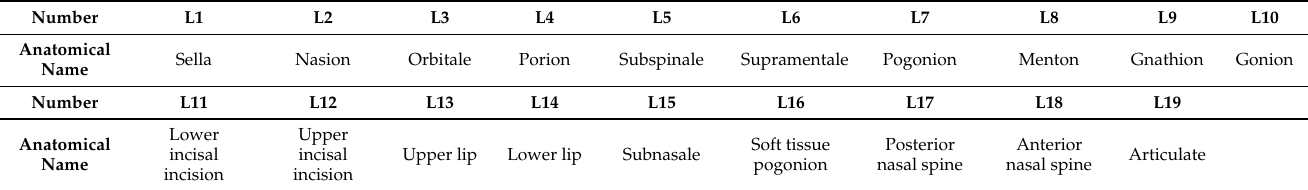
Table 2. List of anatomical